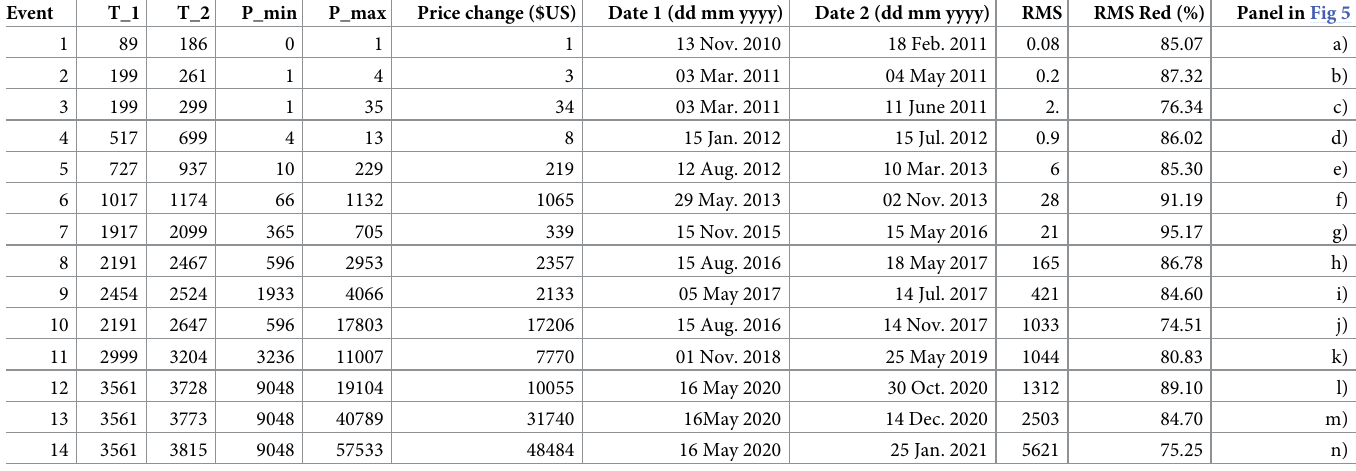
Table 1. Characteristics of time series and statistics of fit curves (Fig 5). The Root Mean Square (RMS) difference between the modeled curve and original time-series never exceeds a ~26%. Average length of subdataset is approx. 190 days (median ~